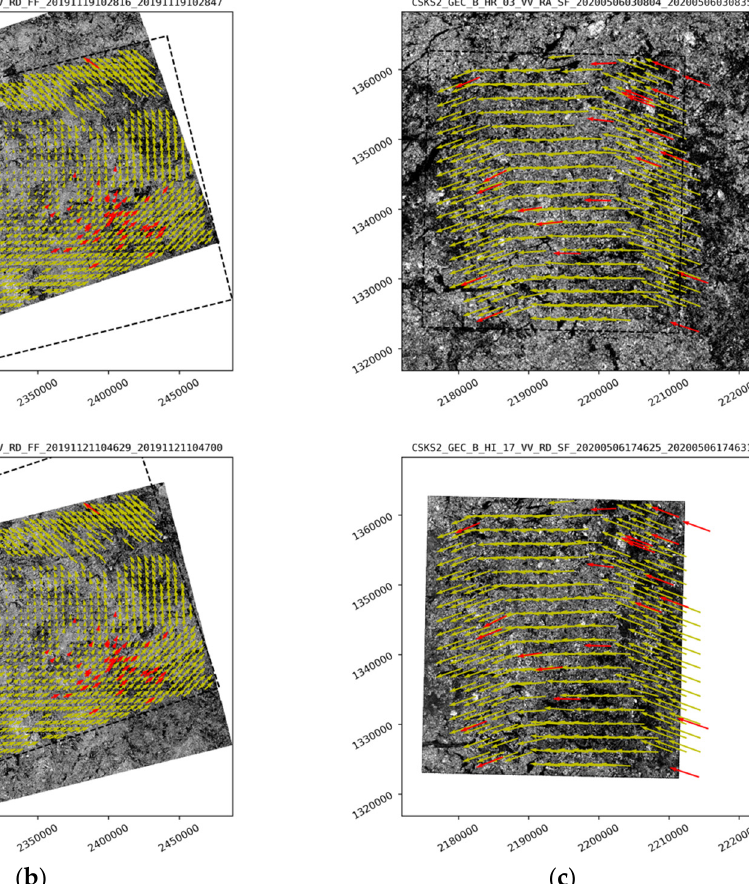
Figure 4. Drift vectors overlaid on the primary (top panels) and secondary (bottom panels) images of COSMO-SkyMed: (a) Stripmap–Stripmap mode, (b) ScanSAR–ScanSAR mode, and (c) Stripmap–ScanSAR mode. Yellow and red arrows represent the results from pattern matching and SVP buoy record, respectively. Black dotted line indicates the footprint of paired image. Note that the pattern matching result vectors are not fully shown (2 km and 5 km spacing in (a, c) and (b) for display). The naming convention of CSK product is CSKS<i>_<YYY_Z>_<MM>_<SS>_<PP>_
<o>_<D><G>_<YYYYMMDDhhmmss>_<YYYYMMDDhhmmss>, which represent the satellite identifier, product type, imaging mode, swath identifier, polarization, look side, orbit direction, delivery mode, state of selective availability, sensing start time, and sensing stop time,